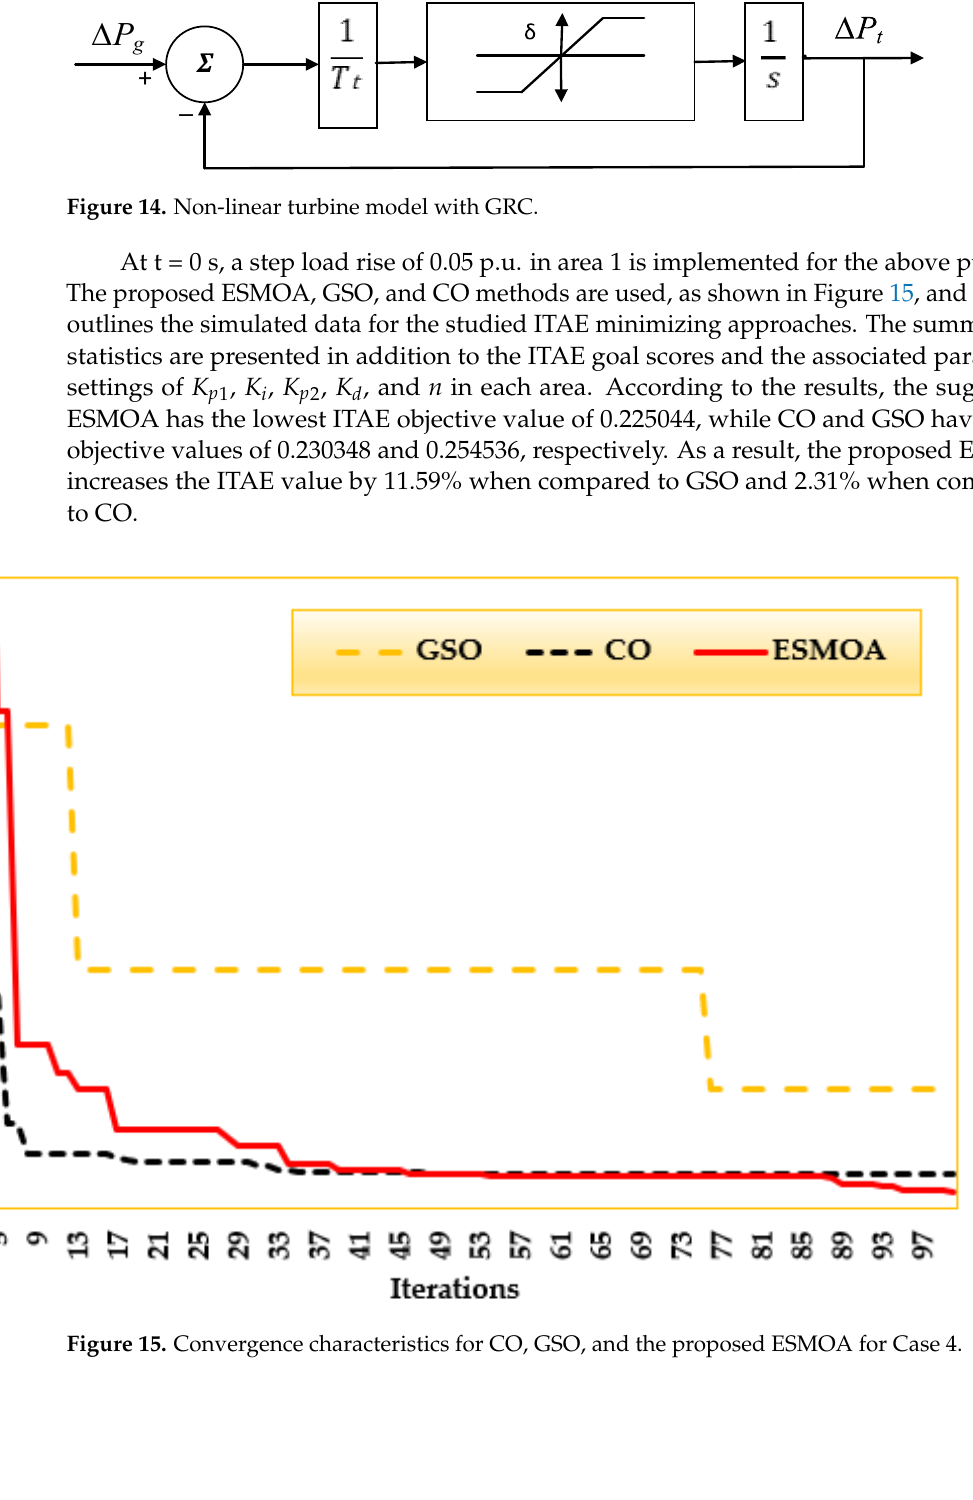
Figure 15. Convergence characteristics for CO, GSO, and the proposed ESMOA for Case 4.